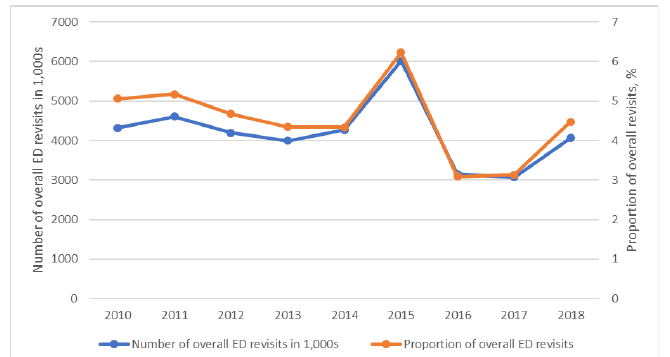
Figure 2. The number and proportion of overall emergency department revisits, 2010-2018.